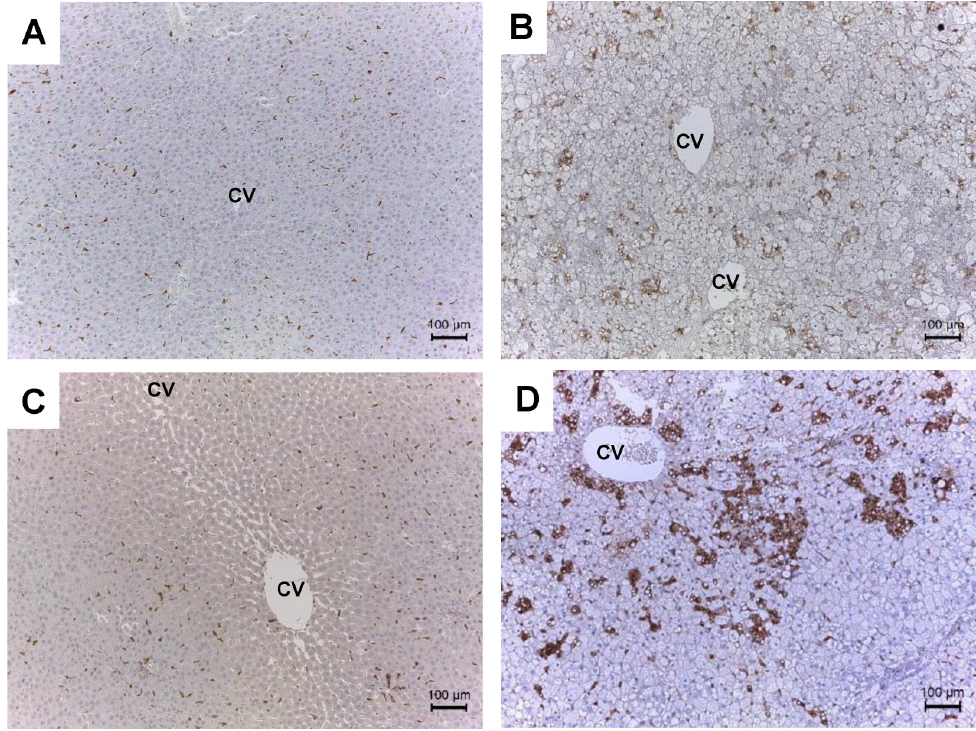
Fig 2. Images of liver sections in the first experiment. Representative images of liver sections subjected to immunostaining with CD68 antibody. Liver sections from normotensive WKY rats fed control (A) or HFC diet (B) and hypertensive SHRs fed control (C) or HFC diet (D) [magnification: × 100]. Scale bar, 100 μ m. CV, central vein; CD68, cluster of differentiation 68.